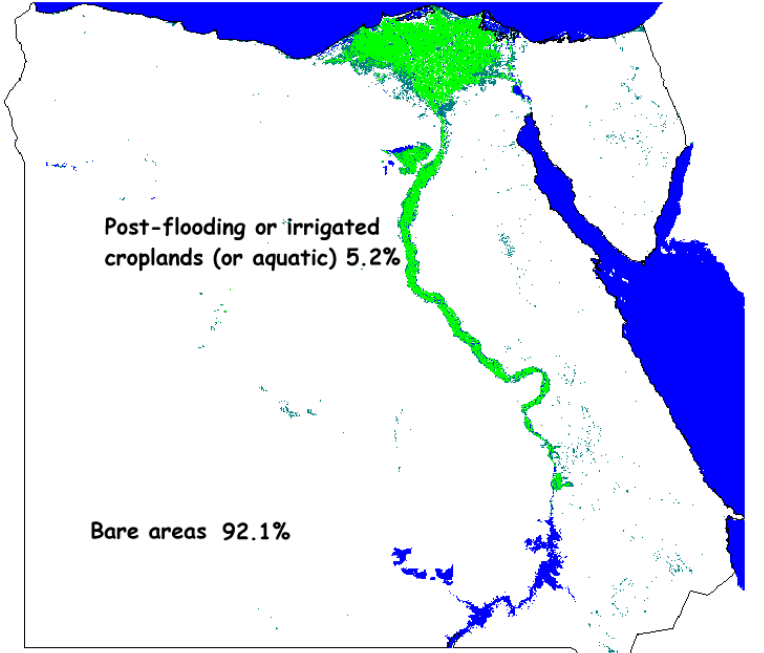
Figure 12. The GlobCover (© ESA/ESA GlobCover Project, led by MEDIAS-France) lancover map of the study